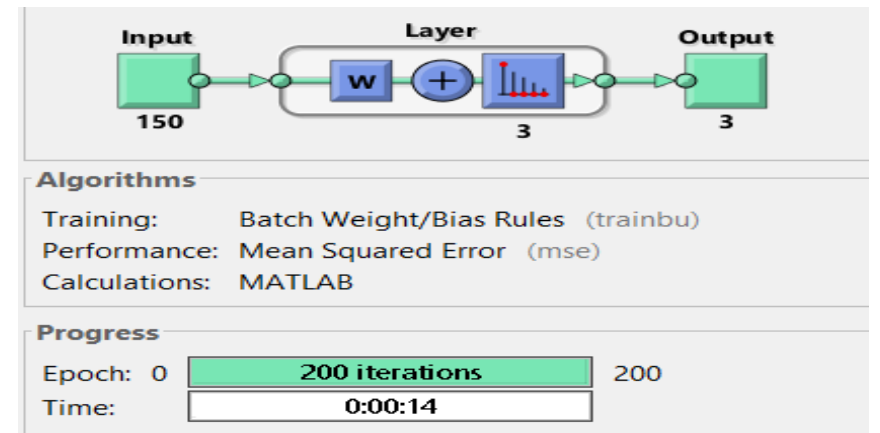
Figure 5. Neural network architecture.